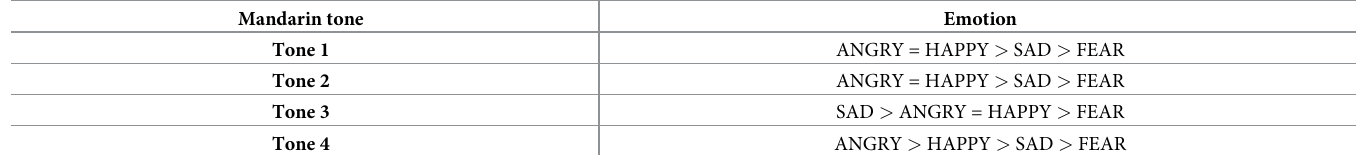
Table 6. Summary of pairwise comparisons for emotion recognition accuracy as a function of Mandarin tone. The symbol > indicates a significant difference ( p < .05) and = indicates no significant